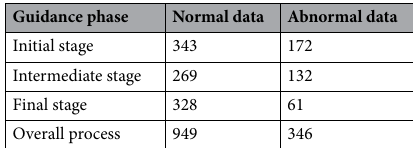
Table 2. Experimental data set.